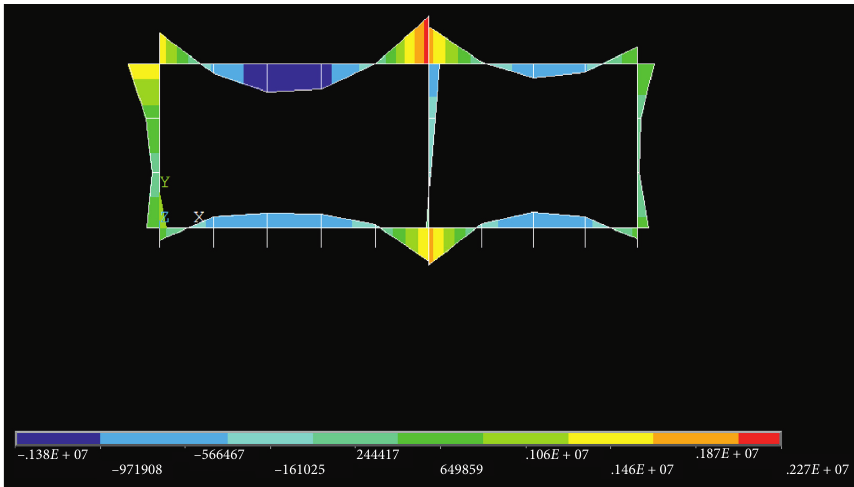
Figure 3: The distribution of bending moment (unit: N ·